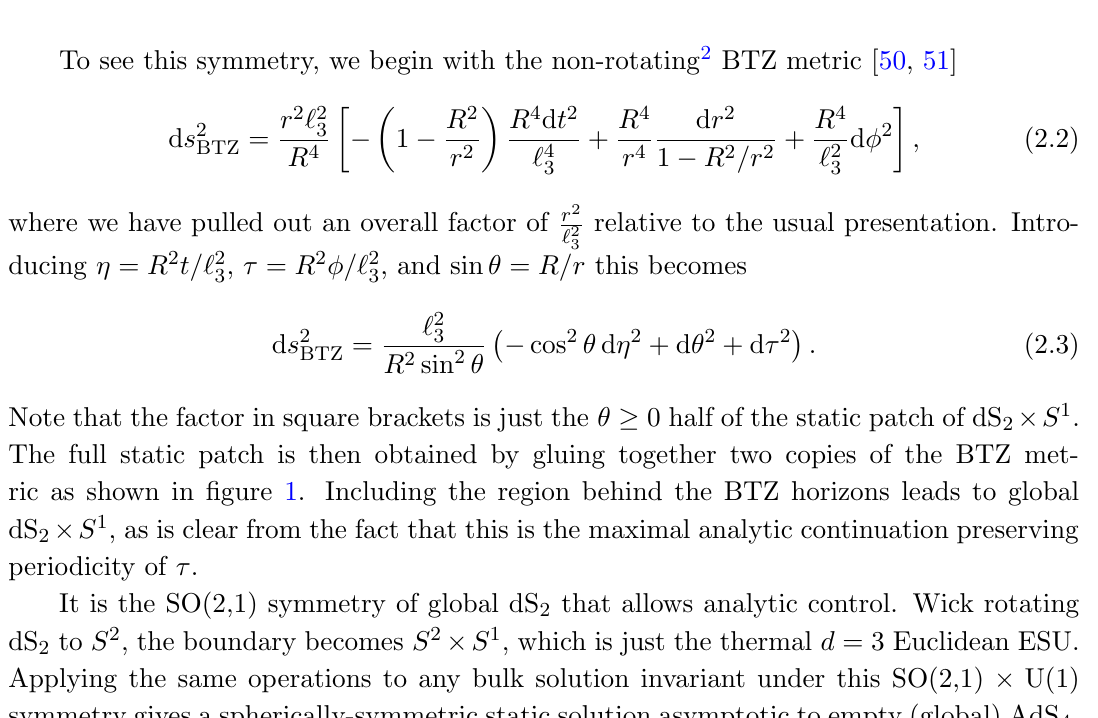
Figure 3 . Dashed lines showing the one-parameter families of boundary conditions studied in [25] (reviewed in section 2.3) for d = 3 (left) and below for d = 4 (right) as plotted on the phase diagram from (cid:12)gure 2. The boundary metrics studied in [25] contain BTZ black holes while those studied below are Schwarzschild Anti-de Sitter (SAdS). Recalling that fat and uniform funnels should be connected by a cross-over in d = 3, the left diagram predicts a transition from droplets at small R; T to funnels at large R; T . Since the droplet-plus-black-hole phase is beyond the scope of this work, the right diagram predicts that we will (cid:12)nd fat funnels to dominate at small R and that either fat or uniform funnels will dominate at large R . Other phases may of course be possible at intermediate values of